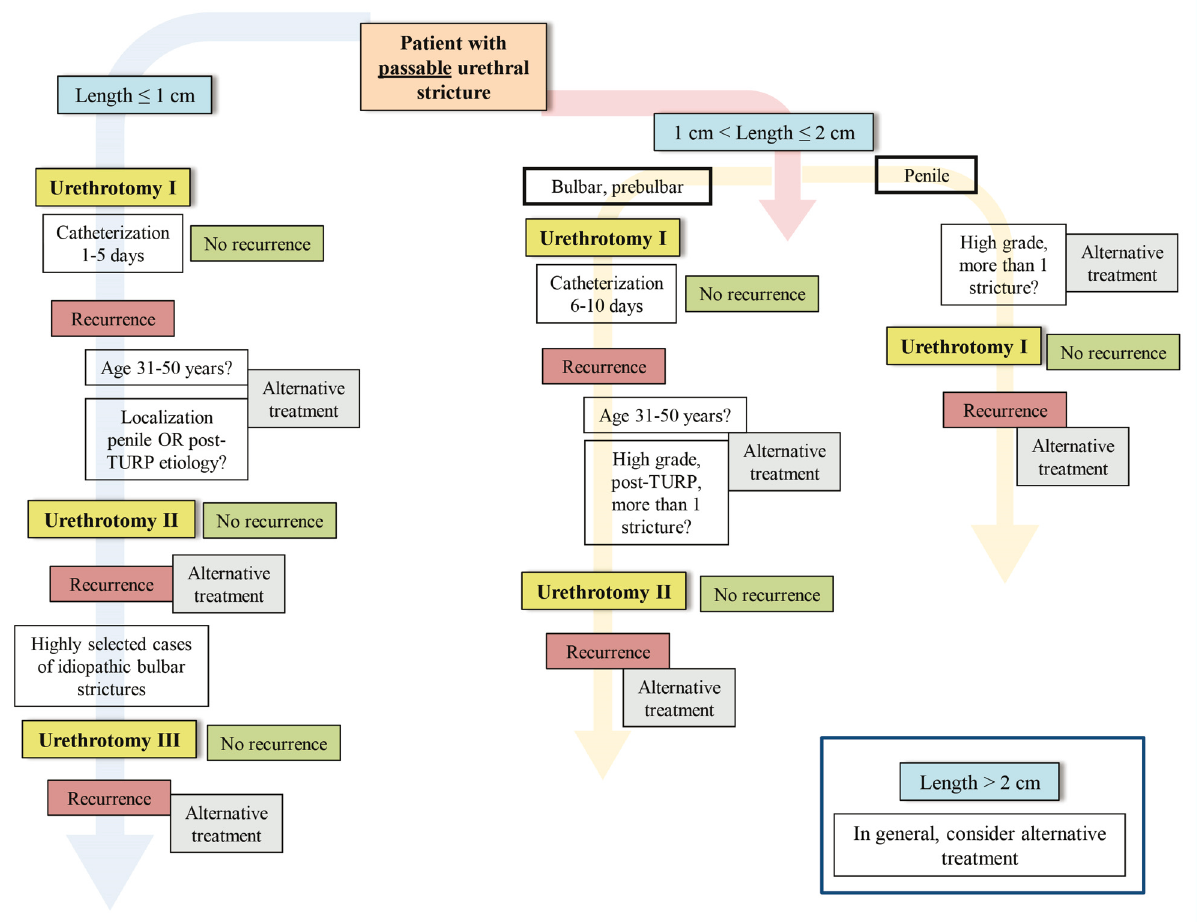
Figure 2. Clinical decision algorithm for patient selection for internal optical urethrotomy according to the clinical parameters and stricture characteristics and ideal time of catheterization (with exclusion of the traumatic strictures and post-prostatectomy anastomotic